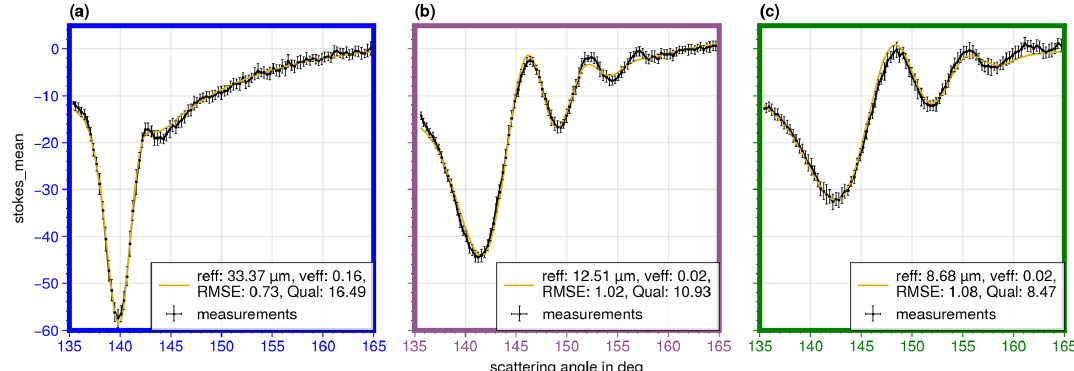
Figure 9. The aggregated polarized radiance measurements of the green channel of the locations shown in Fig. 7 were binned to a 0 . 3 ◦ resolution in the scattering angle (black dots connected by black lines). The error bars represent the standard deviations of all original data points within a 0 . 3 ◦ bin. The yellow lines indicate the best-fitting simulations. The parameters r eff , v eff , RMSE, and Qual of the best-fitting simulations are shown in the boxes in the lower right.